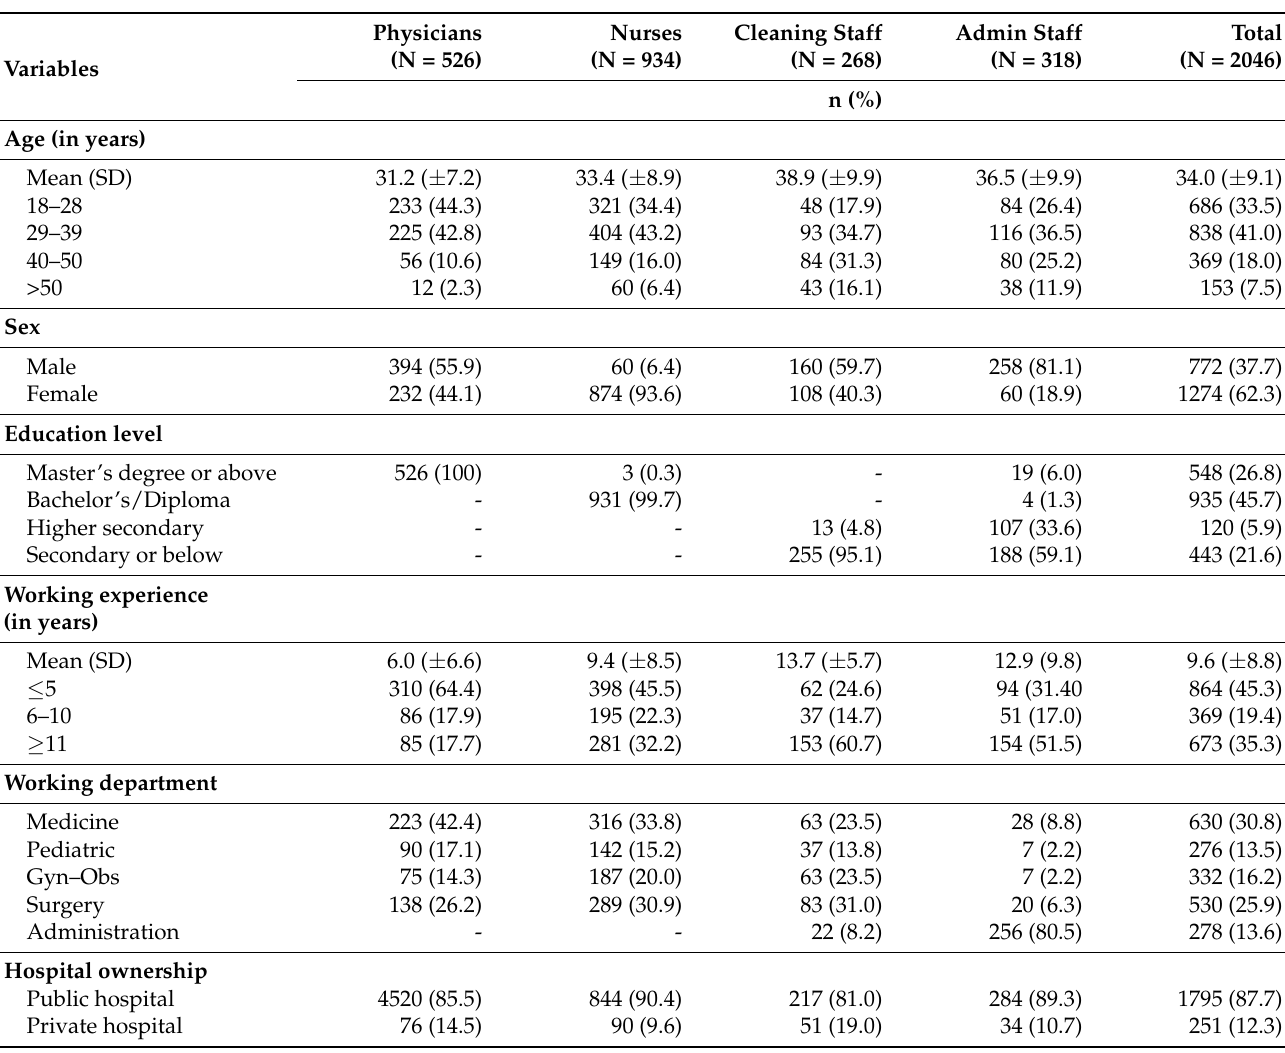
Table 1. General characteristics of participating healthcare workers